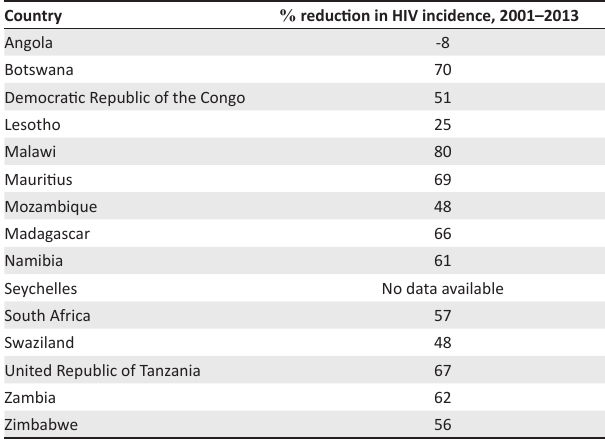
TABLE 3: Percent reduction of HIV incidence 2001–2013 (Southern African Development Community